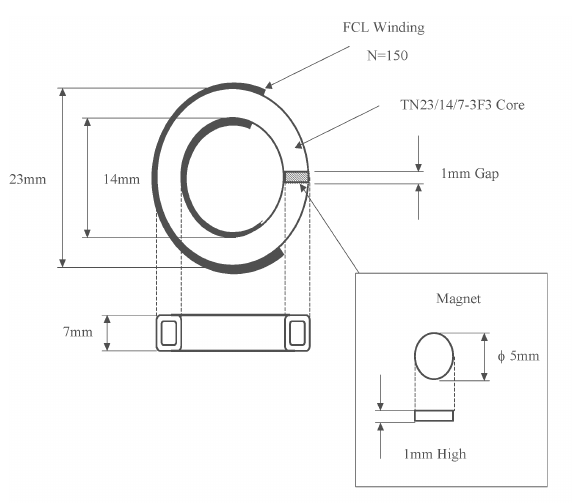
Figure 10: FCL Based on TN29/19/17.6-3F3 Toroid The toroid was wound with 150 turns, cross sectional area of 30.9mm 2 , magnetic path length 55.8mm. The effec- tive inductance was measured with and without the magnet in place. The magnet used was a NdFeB permanent magnet, 5mm diameter and 1mm